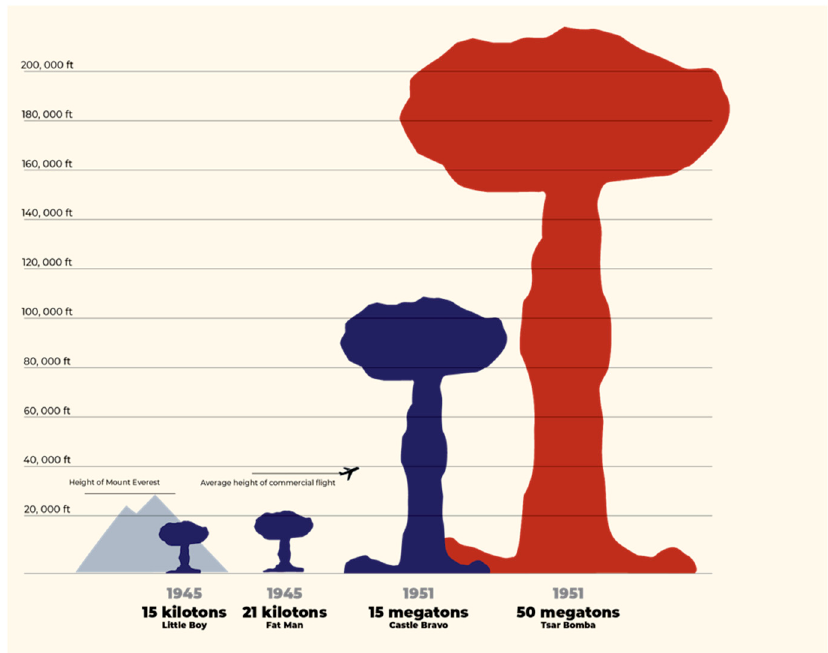
Figure 2. Nuclear Weapons Comparison. Source: Los Alamos National Laboratory (LANL) https://www.lanl.gov/discover/publications/national-security-science/2020-summer/vela-feature.shtml (accessed on 5 May 2022).